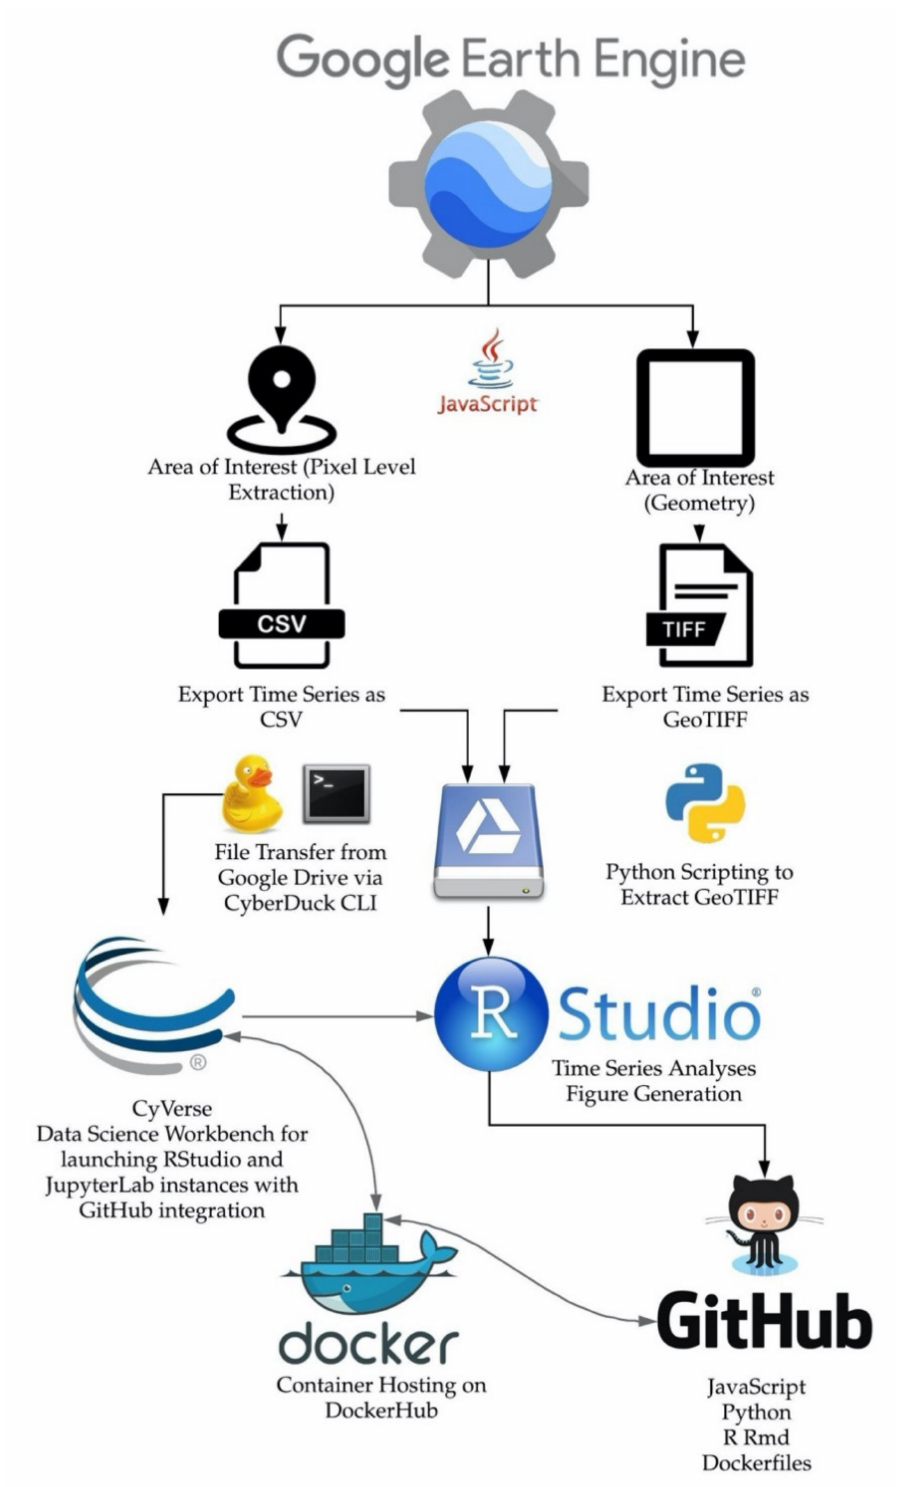
Figure 3. Data are extracted from GEE using either a pixel area of interest, or an entire spatial raster. Data sets use the GEE Python application programming interface (API) to move data directly onto Google Drive, where they are then downloadable to a local compute host, or onto the CyVerse Data Store. The computational notebooks are hosted on GitHub and can be run locally or on a Docker container running in